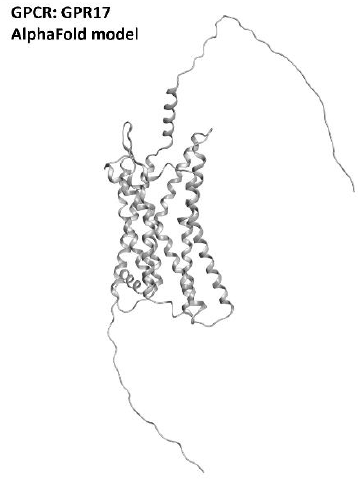
Figure 15. Structure of the GPR17 receptors (with no experimentally resolved structure available, the model sourced from the AlphaFold database is presented). The image was created and rendered with MOE.